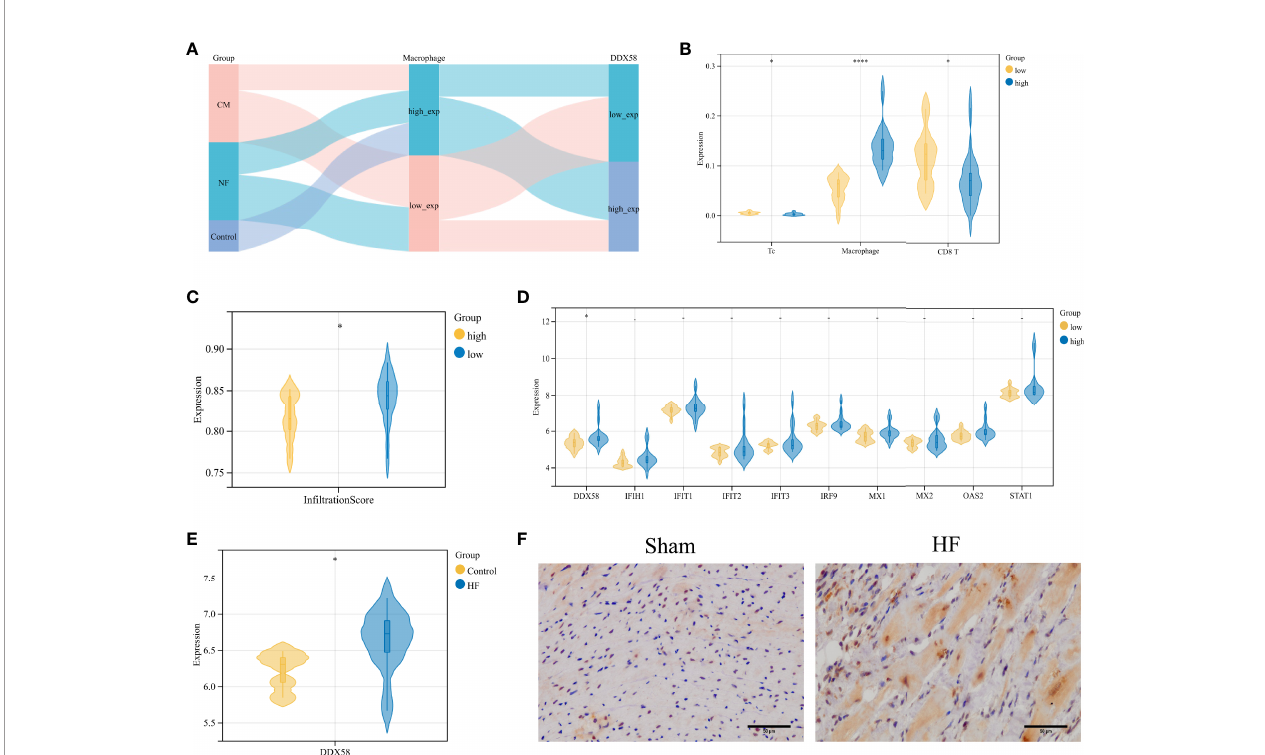
FIGURE 5 | Validation of potential biomarkers for ischemic heart failure (A) Sankey diagram of GSE42955; (B) Comparison of Macrophage, Tc, CD8 + T cell in fi ltration abundance in high and low Macrophage in fi ltration groups in GSE42955; (C) Differences in immune in fi ltration abundance in high Macrophage in fi ltration and low Macrophage in fi ltration groups; (D) Differences in expression levels of 10 genes in high Macrophage in fi ltration and low Macrophage in fi ltration abundance; (E) Expression level of DDX58 in GSE26887; (F) IHC staining of DDX58 in post-infarction heart failure group and sham-operated group (×400). * P < 0.05, **** P <